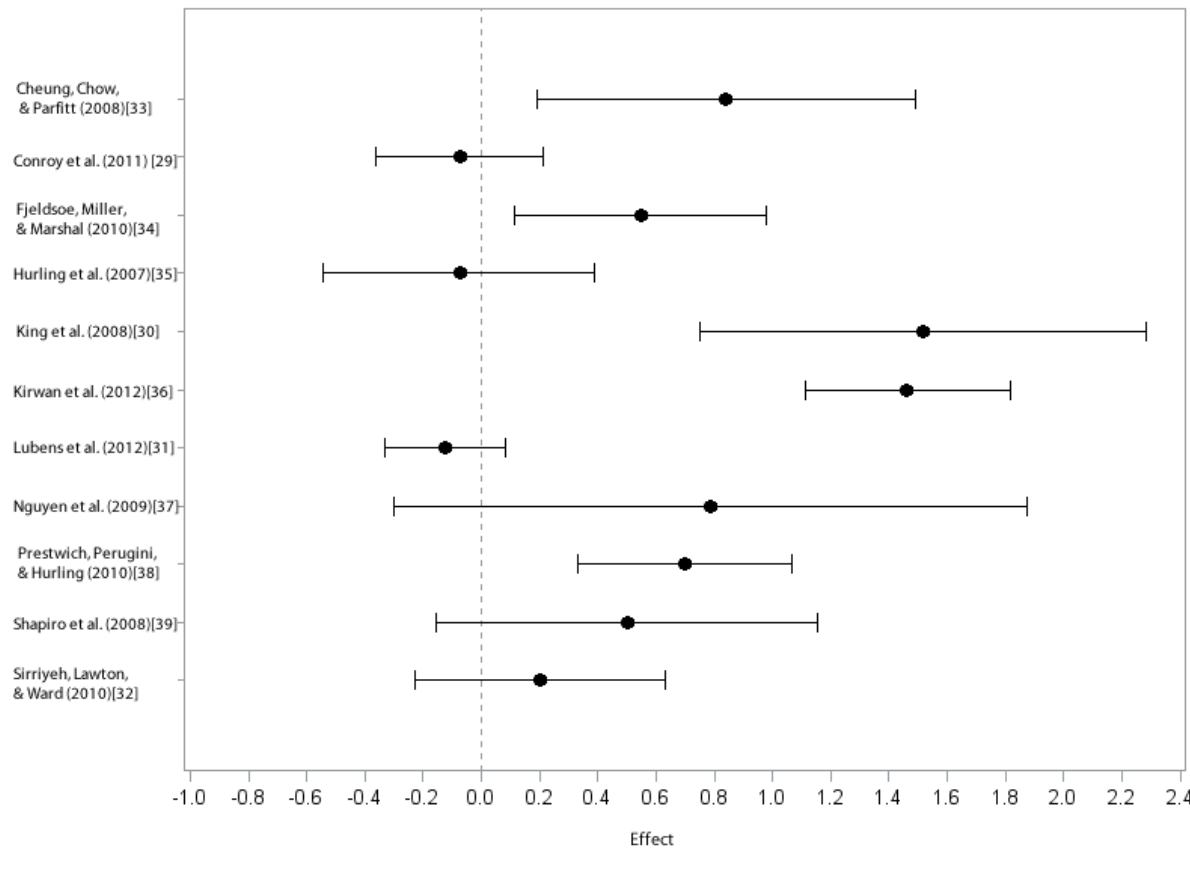
Figure 2. Forest plot of individual effect sizes